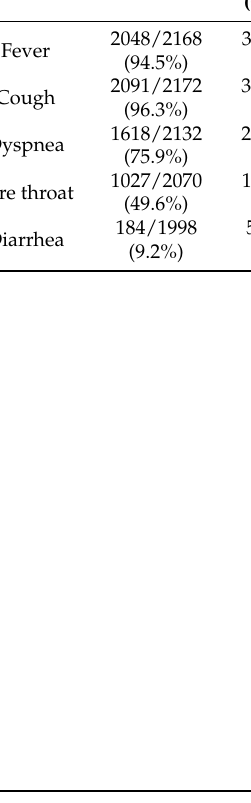
Table 2. Symptoms and outcomes of hospitalized childbearing-aged women with SARS during H1N1 (2009/2010) and COVID-19 (2020/2021) pandemics in Brazil.